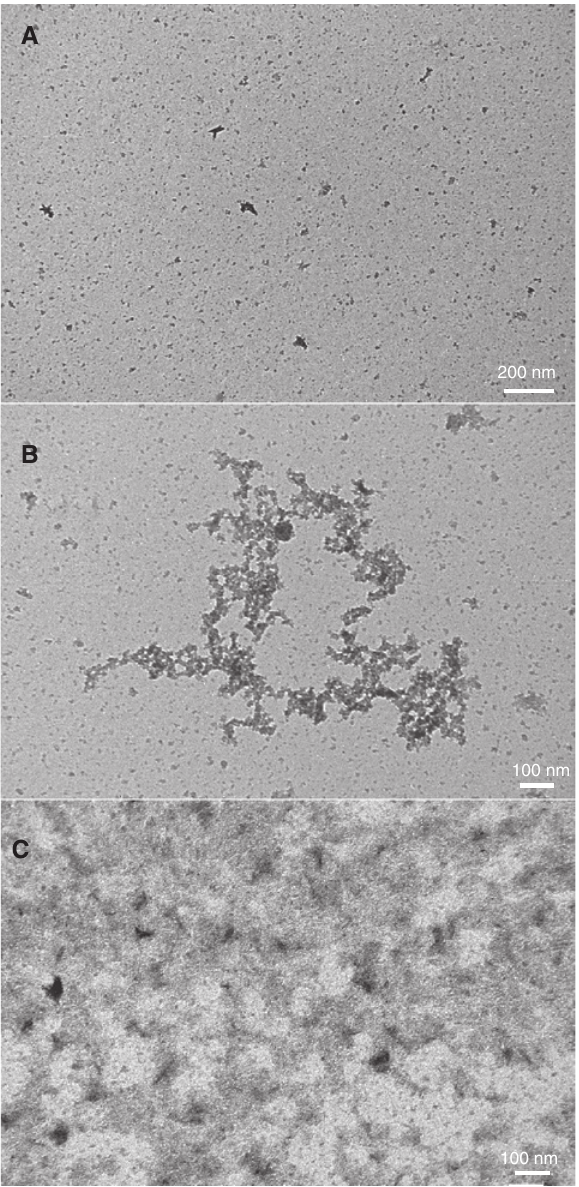
and (B) diluted and 2